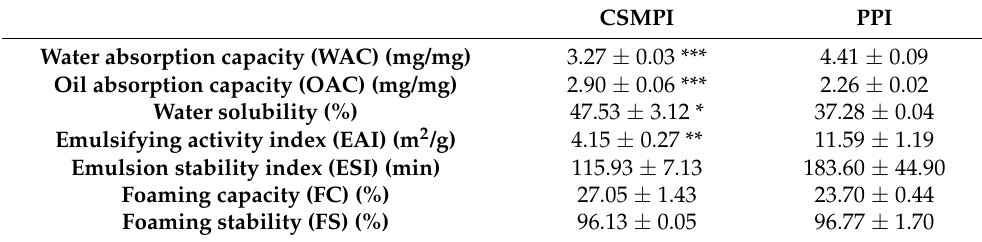
Table 1. Comparison of various functional properties of post-treated CSMPI against pea protein isolate (PPI). All protein isolate solutions were adjusted to pH 7 before functional characterisation. Standard error mean is calculated based on three biological replicates (unpaired t -test, * p < 0.05, ** p < 0.01, *** p <